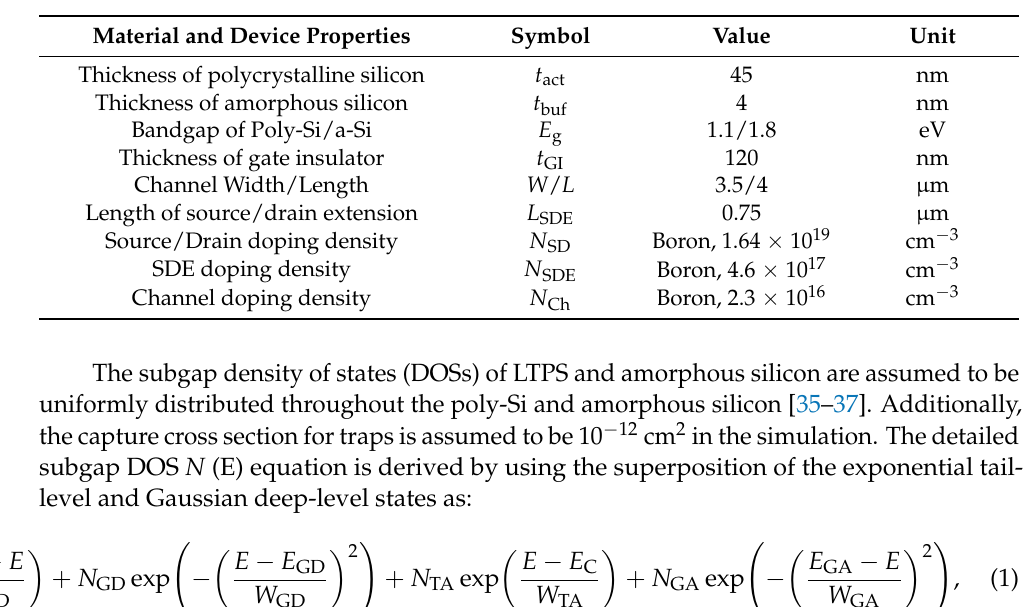
Figure 2. Schematic of the proposed p-type LTPS TFT with an amorphous silicon and source/drain extension. Table 1. Summarized simulated device parameters.